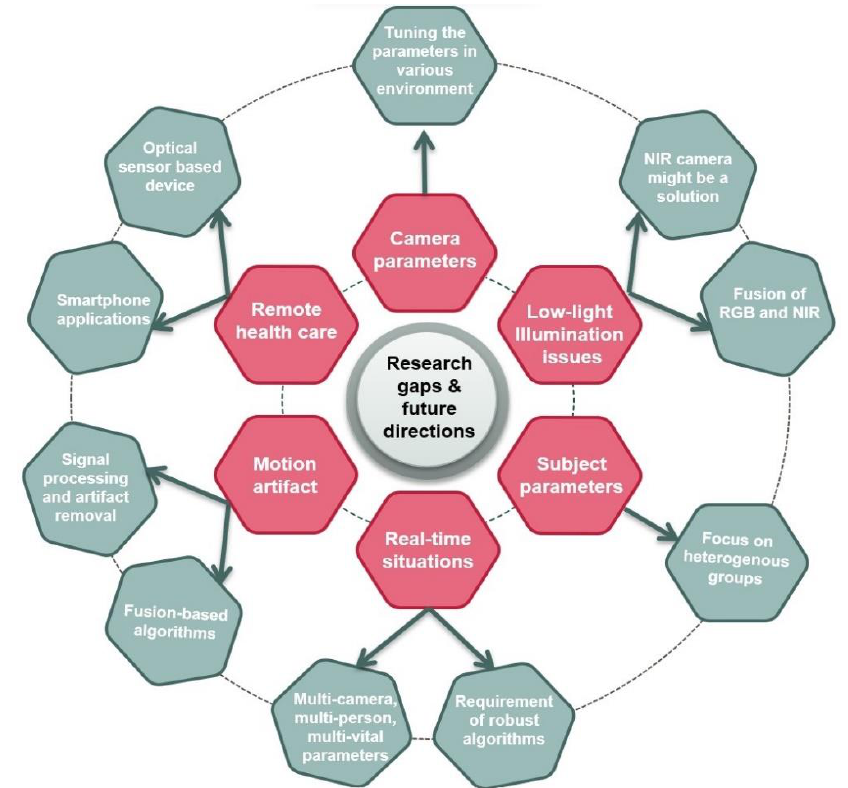
Figure 12. The framework of main research gaps and future directions. In this, red color boxes represent the research gaps, and green color boxes refer to future research directions.